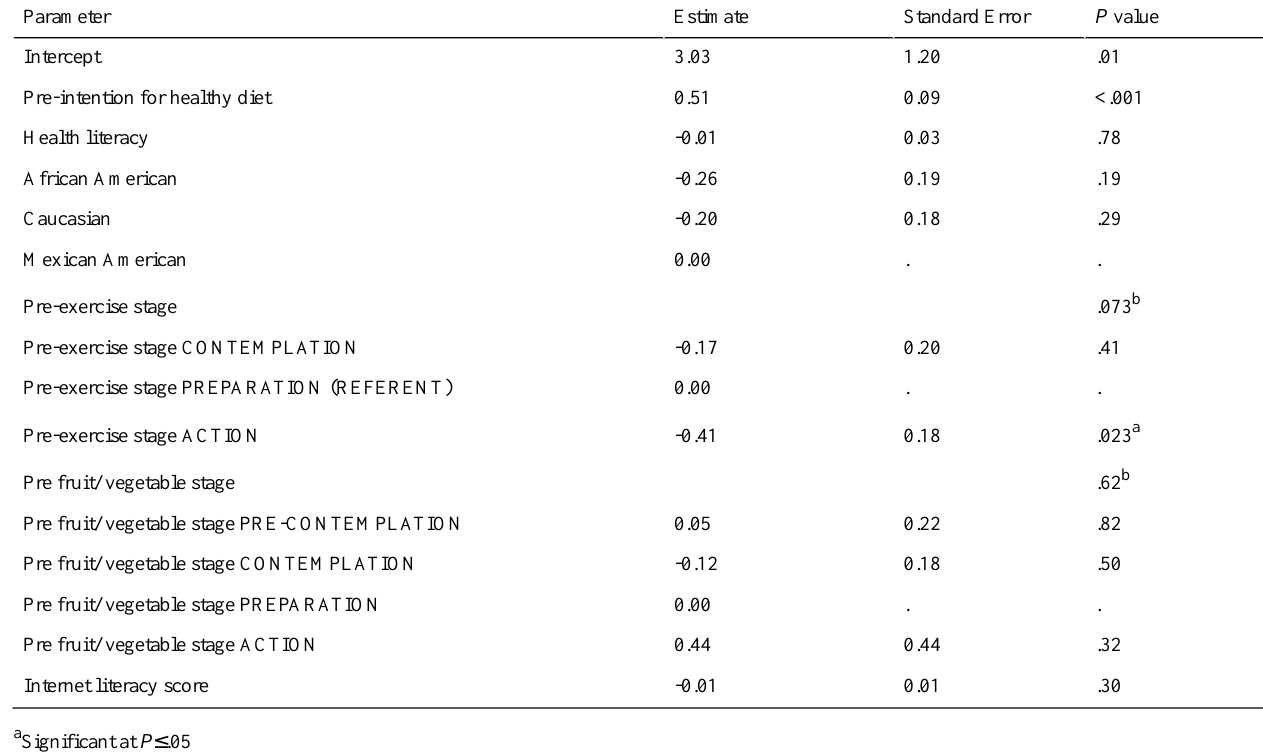
Table 8. Intention to eat a healthy diet post exposure to website controlling for health literacy, ethnicity, transtheoretical model stage for exercise and fruit and vegetable consumption, and Internet